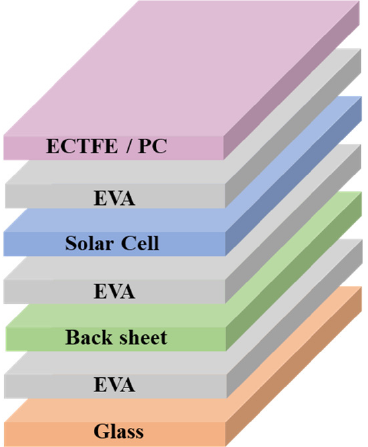
Figure 4. Structure of the PV module according to various front sheet materials.